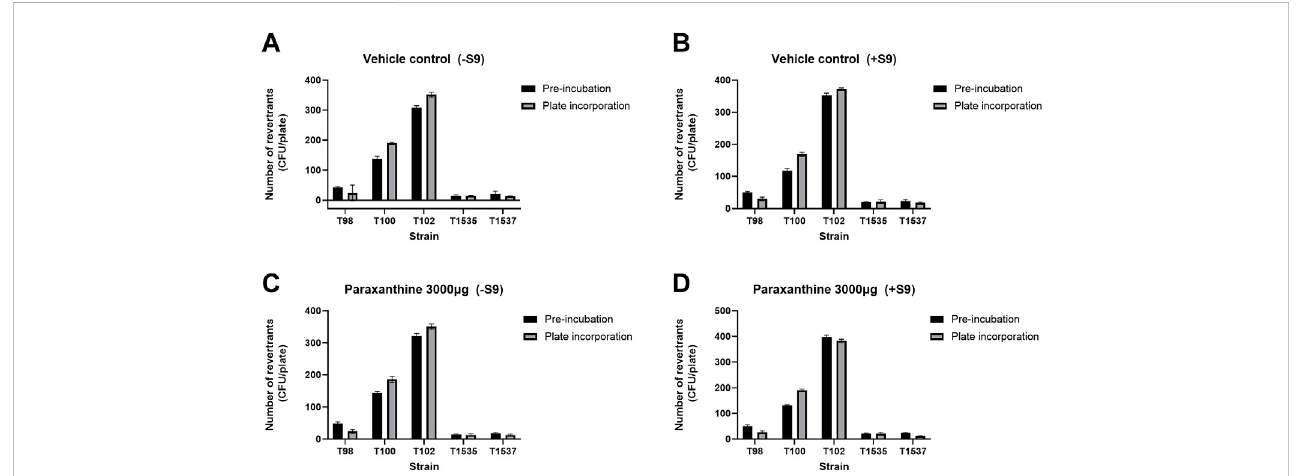
FIGURE 2 Number of His + revertrants in the pre-incubation and plate incorporation method with all strains of Salmonella typhimurium for the vehicle control in the (A) absence and (B) presence of rat liver S9 metabolic activation; and with the highest concentration of paraxanthine (3,000 µg/plate) in the (C) absence and (D) presence of rat liver S9 metabolic activation.